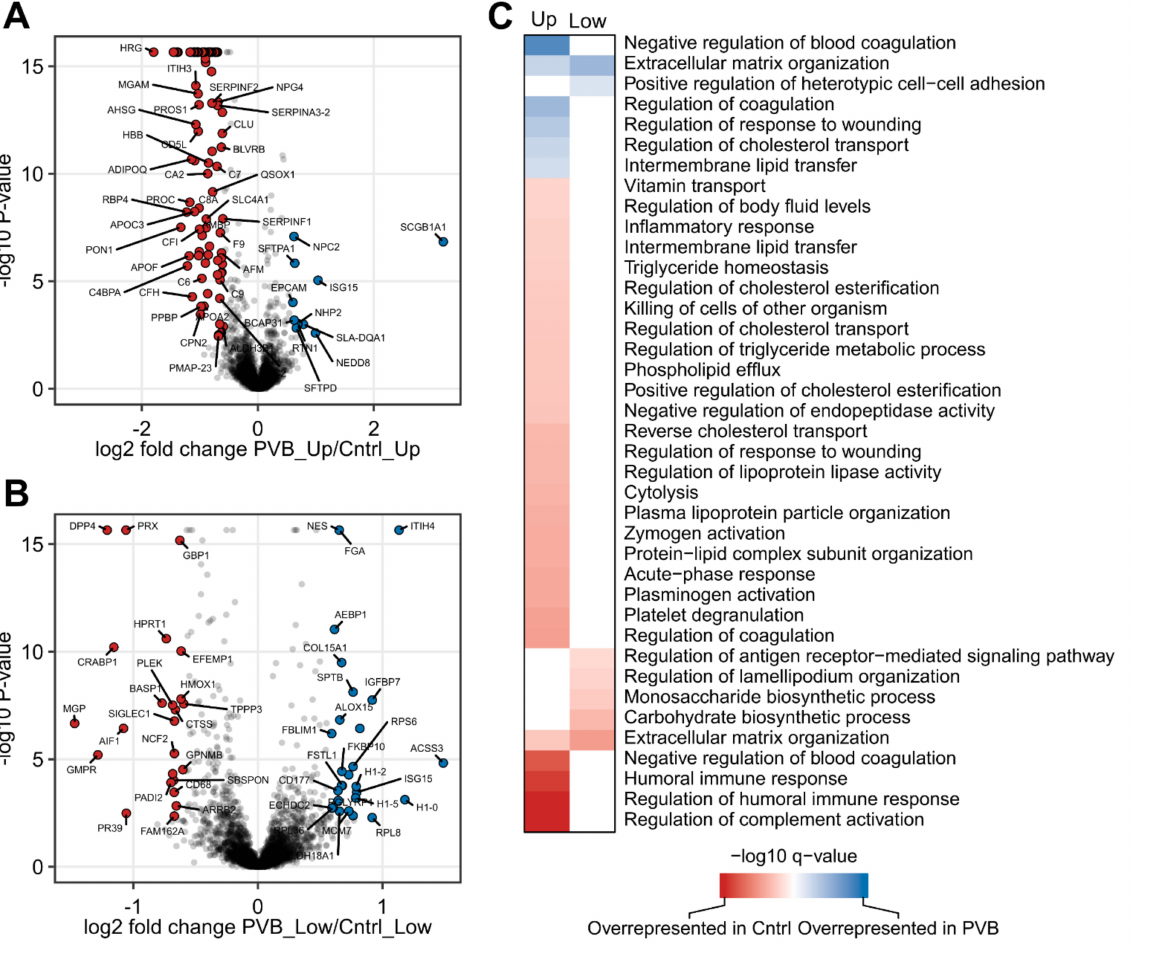
Figure 3. Quantitative and functional analysis of upper and lower lobe of PVB vs. Cntrl animals. ( A , B ) The quantitative proteome alterations are visualized via volcano plots in upper and lower lobes, respectively, from PVB vs. Cntrl pigs. Color-filled circles (blue—upregulated, red—downregulated) indicate differentially abundant proteins (Benjamini–Hochberg corrected p -value ≤ 0.05 and fold change ≥ 1.5). ( C ) Functional characterization of differences between upper and lower lobes in PVB and Cntrl animals. Heatmap shows GO-term enrichment in PVB compared to Cntrl. Cntrl (n = 7); PVB (n =